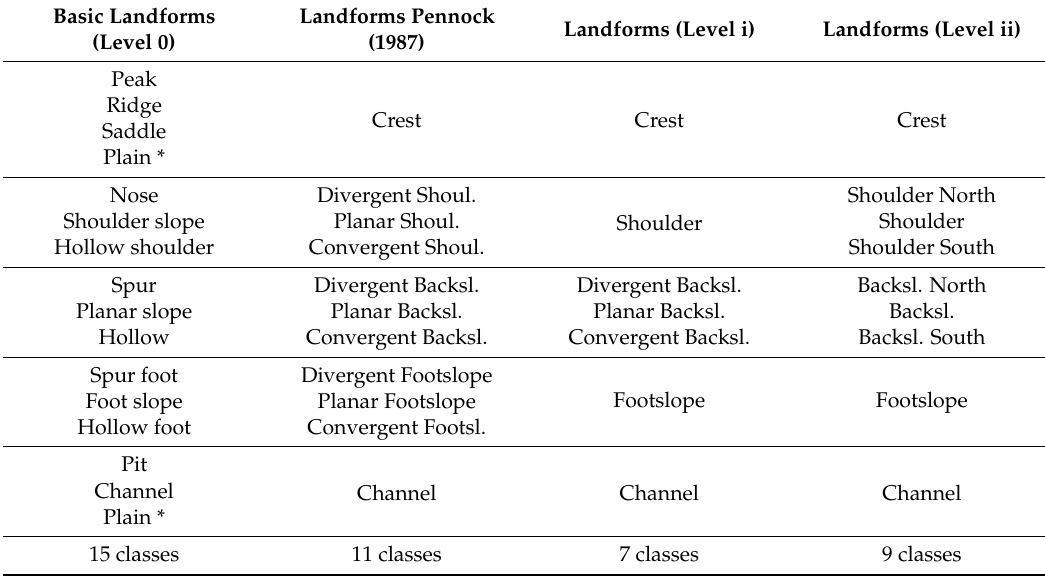
Table 1. Landform